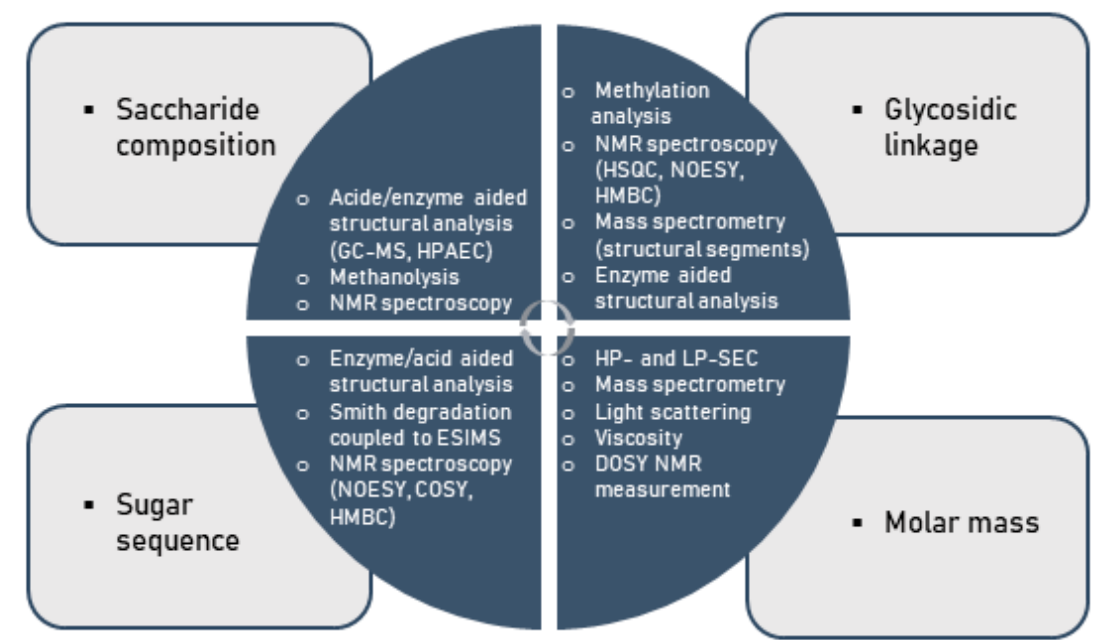
Figure 4. Methods for the chemical characterization of polysaccharides.